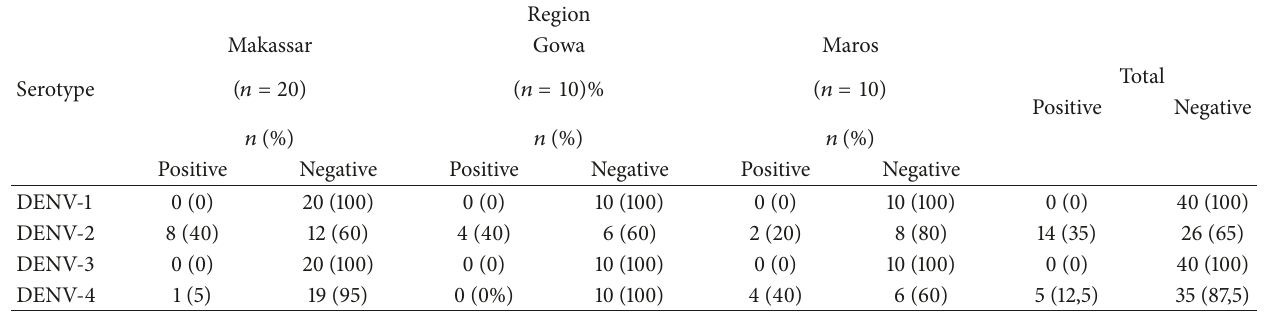
DENV-2 Positive